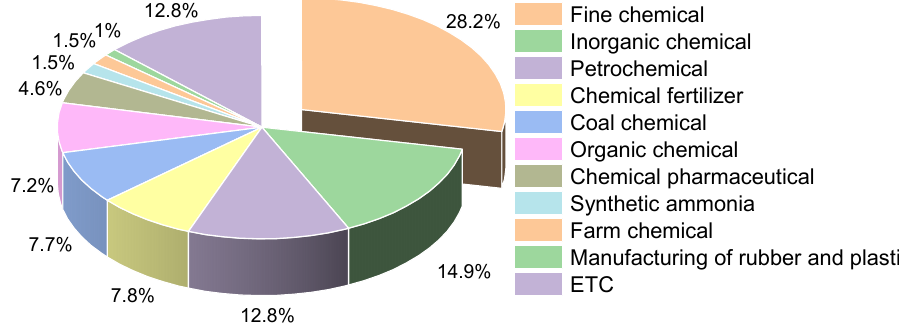
Figure 6. The percentage of HCA and casualties in different industries from 2000 to 2020.